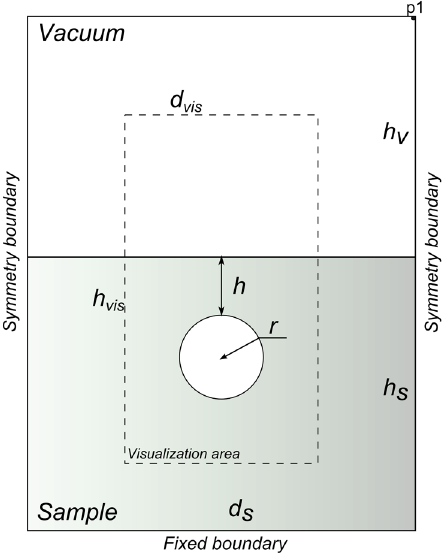
FIG. 1. Geometrical layout of the simulated system. The size of the vacuum and the sample are determined by the heights h V and h S , respectively. The 3D geometry was simulated by using the axial symmetry with the axis at the center of the box shown as a thick dashed line. The thin dashed outline indicates the area used for the visualization of the